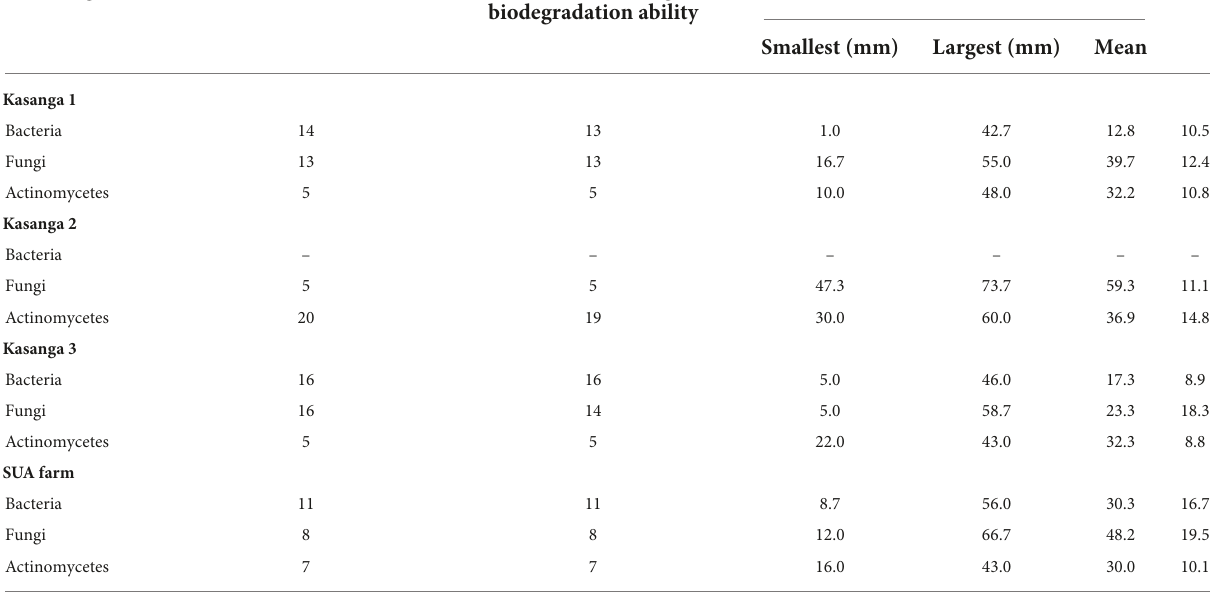
TABLE 3 Screening the abilities of isolated bacteria, fungi, and actinomycetes from four different soils in degrading ground plastic bottles. Soil + organism Number of isolates tested Number showing Diameter of clear biodegradation ability